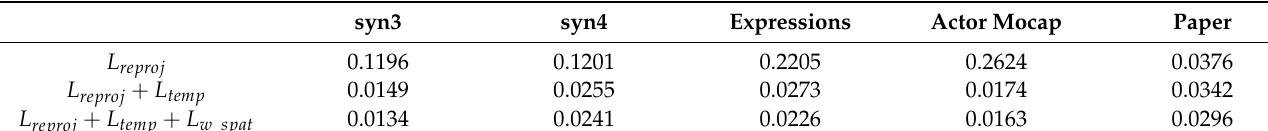
Table 1. Results of ablation experiments.